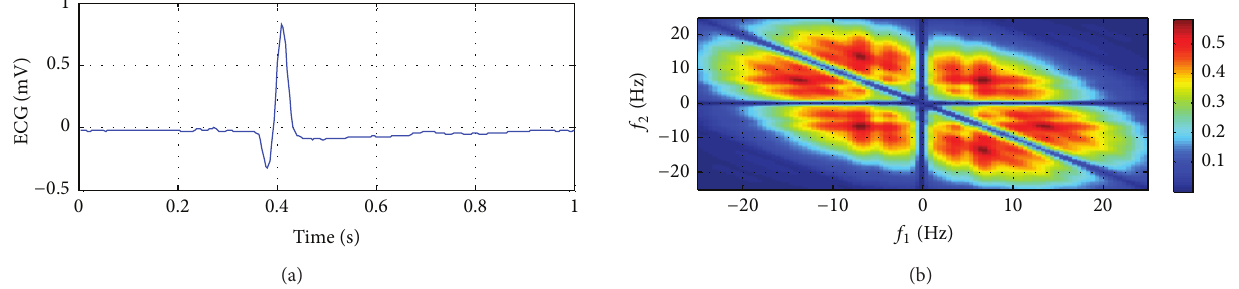
Figure 1: An ECG episode and its bispectrum for patient with nonterminating AF.